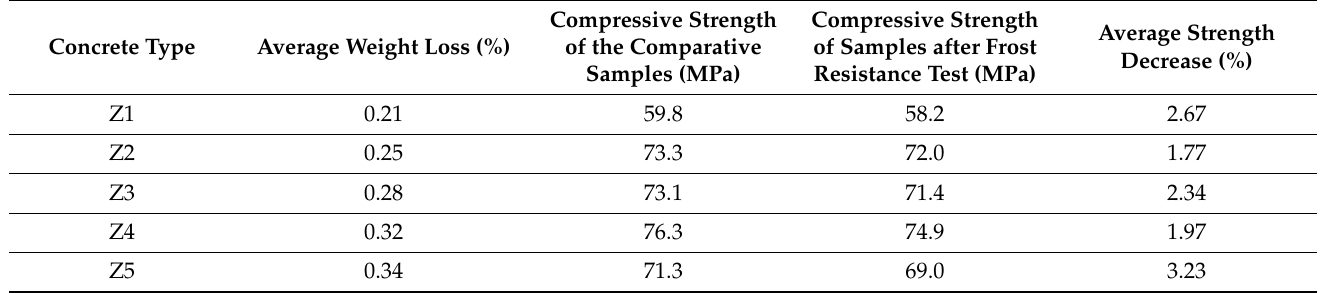
Table 8. Results of the frost resistance